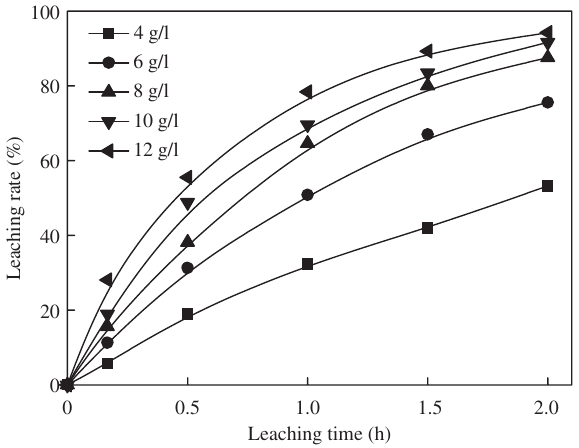
Figure 5: Effect of thiourea mass concentration on silver leaching